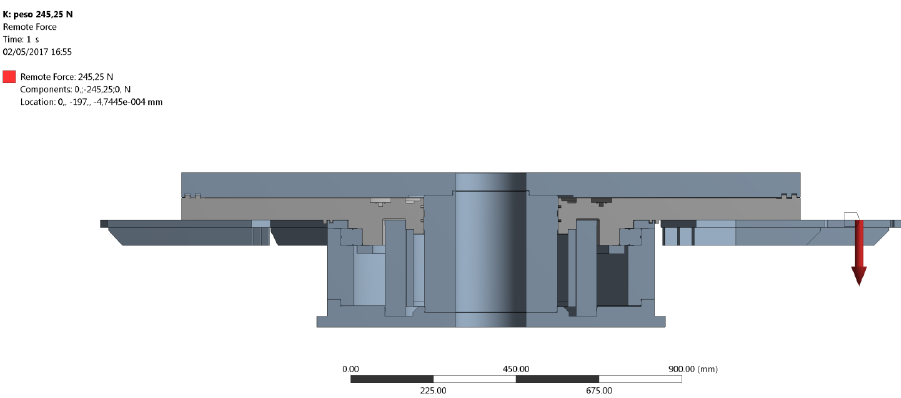
Figure 6. Application of F y to the reference support.